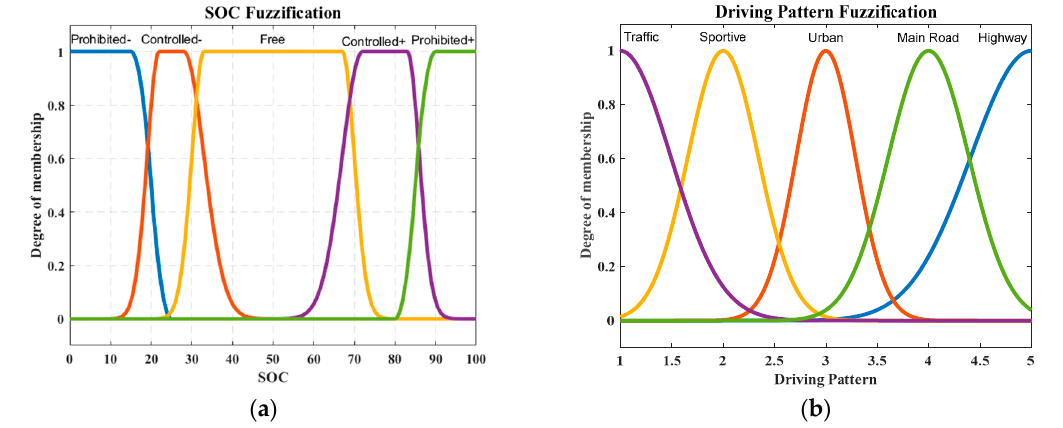
Figure 6. ( a ) “Battery SOC fuzzification”; ( b ) “Driving Patterns Fuzzification”.